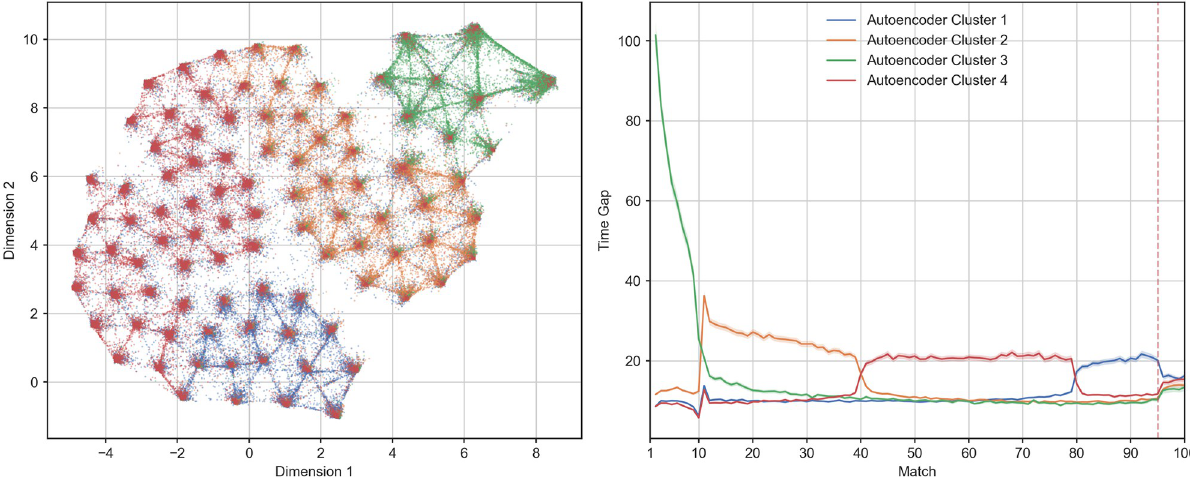
their associated values should be interpreted as coordinates on a plane rather than indicators of the magnitude of the two components. Each dot represents the history of inter-match gaps in hours for a single player while distance between dots indicates the degree of similarity between different patterns of spacing. The right panel shows the average evolution of inter-match gap in hours for players in each spacing cluster . The y axis indicates the time in hours elapsed since the previous match while the x axis indicates the order of the match. The solid line indicates the mean value while the shaded region shows the 95% confidence interval. The dotted red line separates the observation period (i.e., the first 95 matches) from the evaluation period (i.e., the last 5 matches).